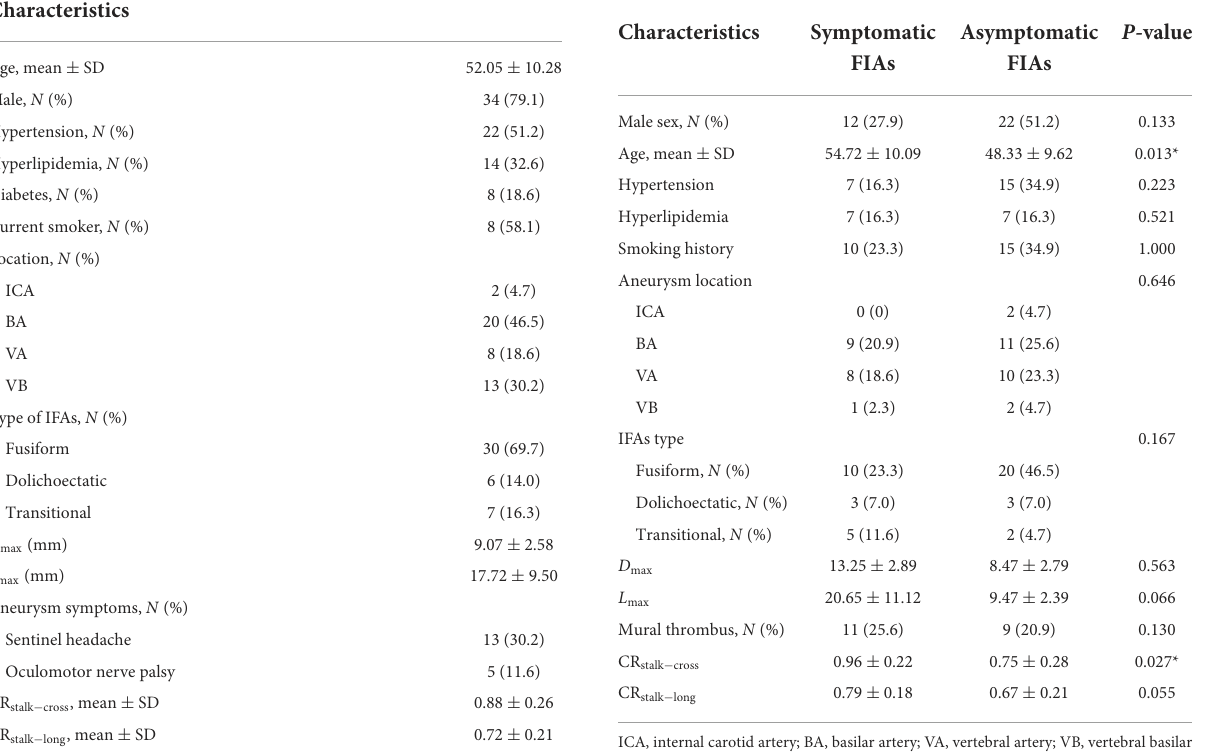
TABLE 1 Characteristics of patients and IFAs. TABLE 2 The association between patients’ and aneurysmal